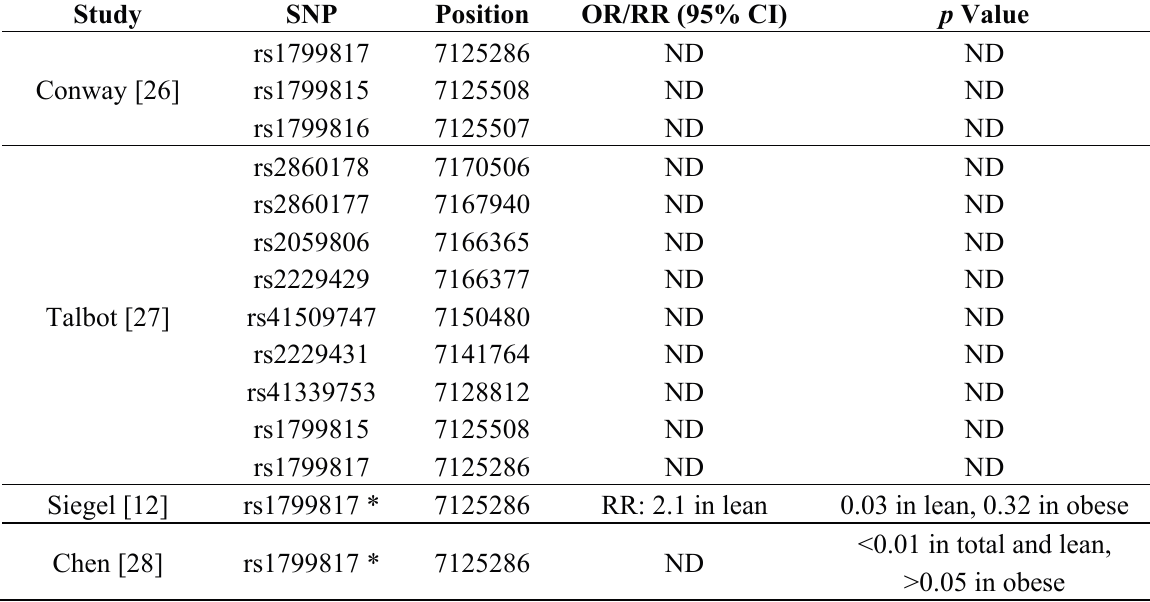
Figure 2. Map of investigated INSR SNPs in former studies. *: SNPs that were found to distribute differentially between PCOS and control. Table 2. Chromosome position and OR/RR of INSR SNPs detected in former